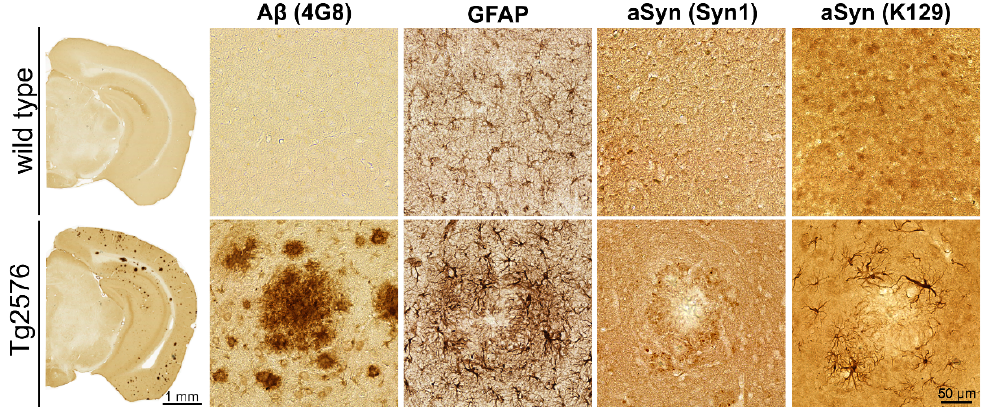
Figure 2. Immunohistochemical detection of A β , GFAP and aSyn in brains of wild-type and Tg2576 mice. In wild-type mouse brain ( top row ), no A β plaques, resting astrocytes and synaptic aSyn localization were observed. In brains of Tg2576 mice ( bottom row ), A β plaques, reactive astrocytes, punctate aSyn aggregates in the periphery of plaques (Syn1 antibody) and glial distribution of aSyn (K129 antibody) were detected. All high magnification images are from entorhinal cortex.